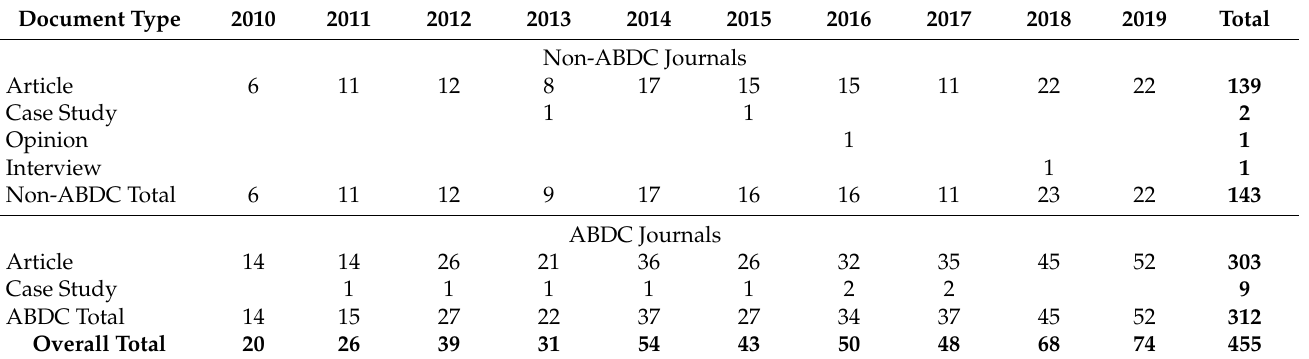
Table 3. Document type for ABDC and non-ABDC